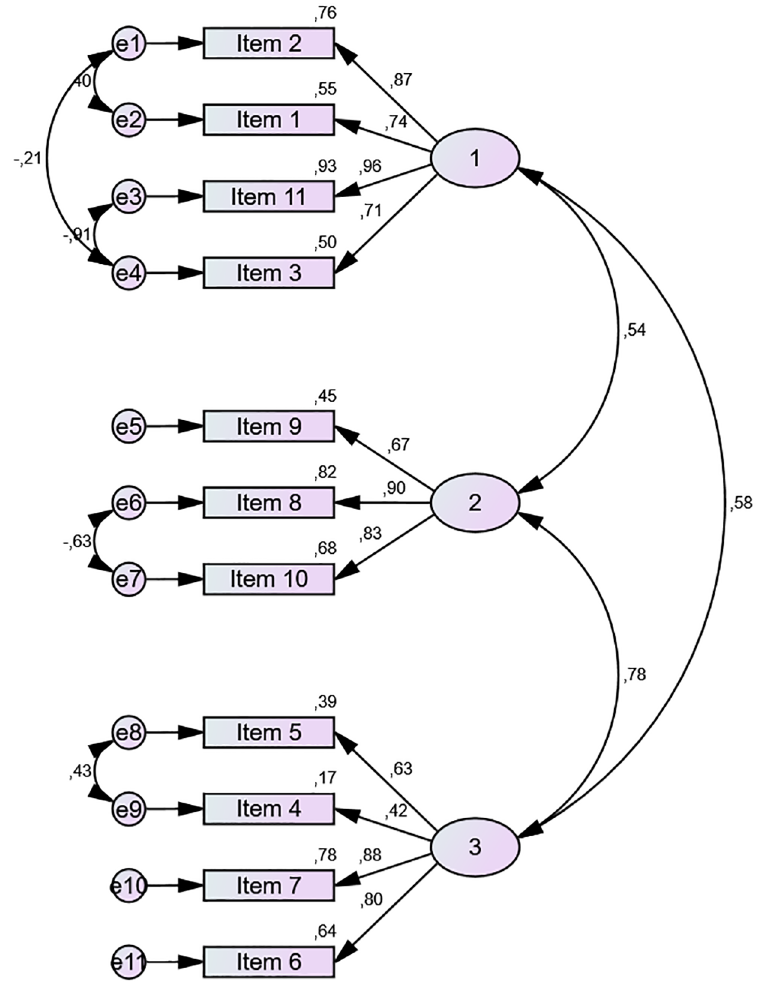
Fig 1. Factor structure of the Spanish version of EdFED.